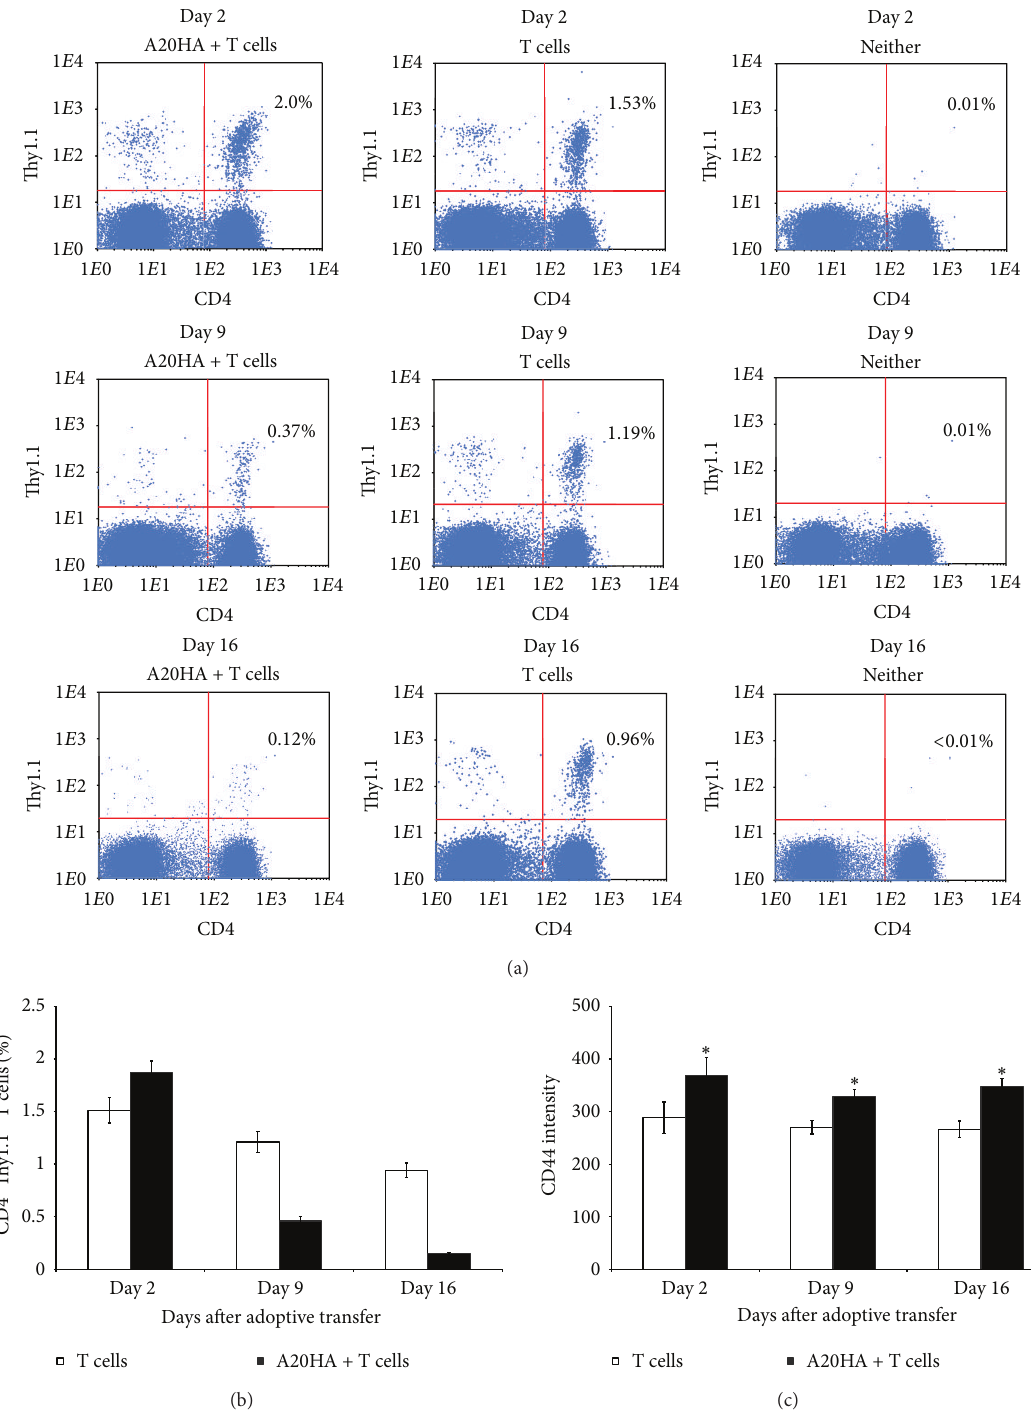
Figure 2: Adoptively transferred HA-specific CD4 + Thy1.1 + T cells demonstrate early activation and following depletion in cervical lymph nodes of A20HA brain tumor-bearing mice. ((a), (b), (c)) Flow cytometry of CD4 + Thy1.1 + CD44 + T cells from cervical lymph nodes on days 2, 9, and 16 after adoptive transfer. HA-specific CD4 + Thy1.1 + T cells were injected i.v. into A20HA brain tumor-bearing mice 5 days after i.c. tumor inoculation (A20HA + T cells; left column) and tumor-free control mice (T cells; middle column). Naive mice represented a negative control (Neither; right column). Each group included three mice. Cervical lymph nodes were analyzed individually from each mouse by three-color FACS assay. A representative experiment among three equivalents is shown. (a) Dot plots show gated HA-specific CD4 + Thy1.1 + T cells (upper right quadrants; numbers in the quadrants indicate percent cells in each). Bars show (b) percent of HA-specific CD4 + Thy-1.1 + T cells and (c) intensity of CD44 expression in the gated population of CD4 + Thy-1.1 + T cells. Data are represented as the mean ± SD, 𝑛 = 3 . ∗ 𝑃 < 0.05